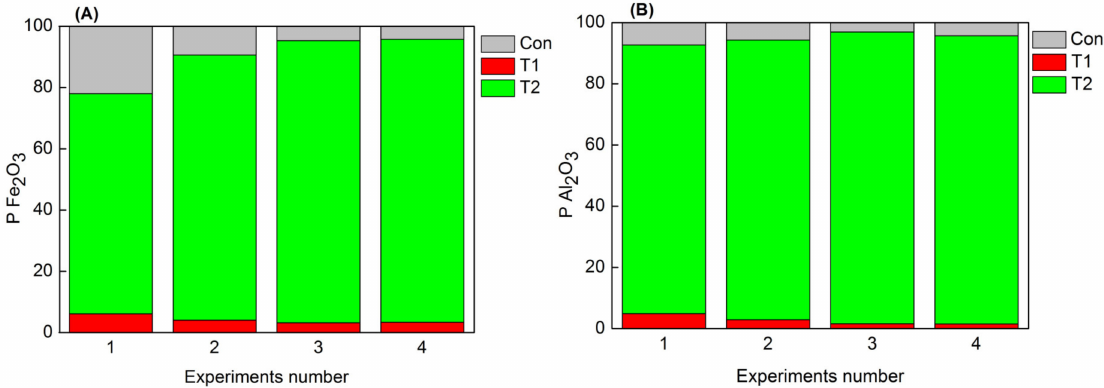
Figure 5. Distribution ratio of Fe 2 O 3 ( A ) and Al 2 O 3 ( B ) in T1, T2 and concentrate (Con) at different experiment